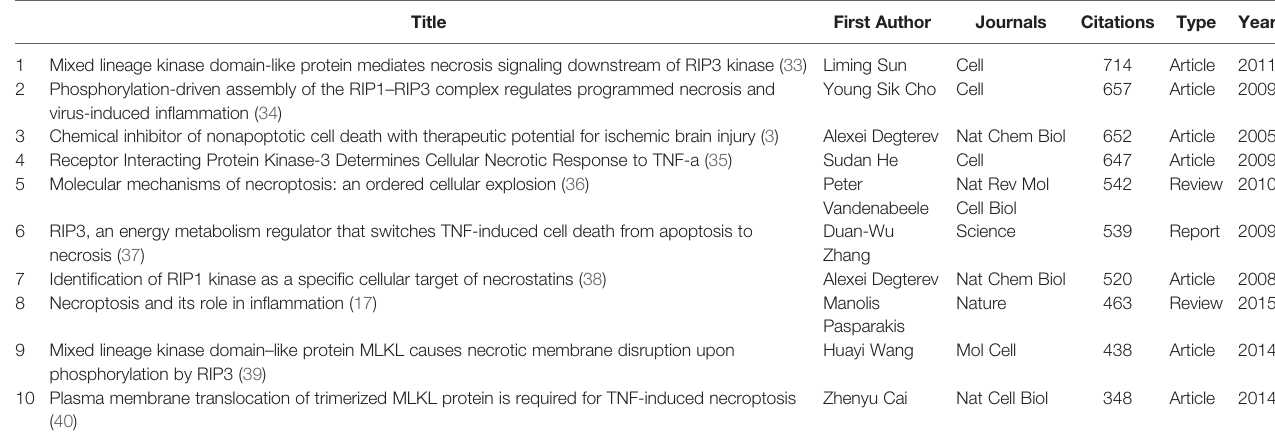
TABLE 4 | Top 10 co-cited references related to